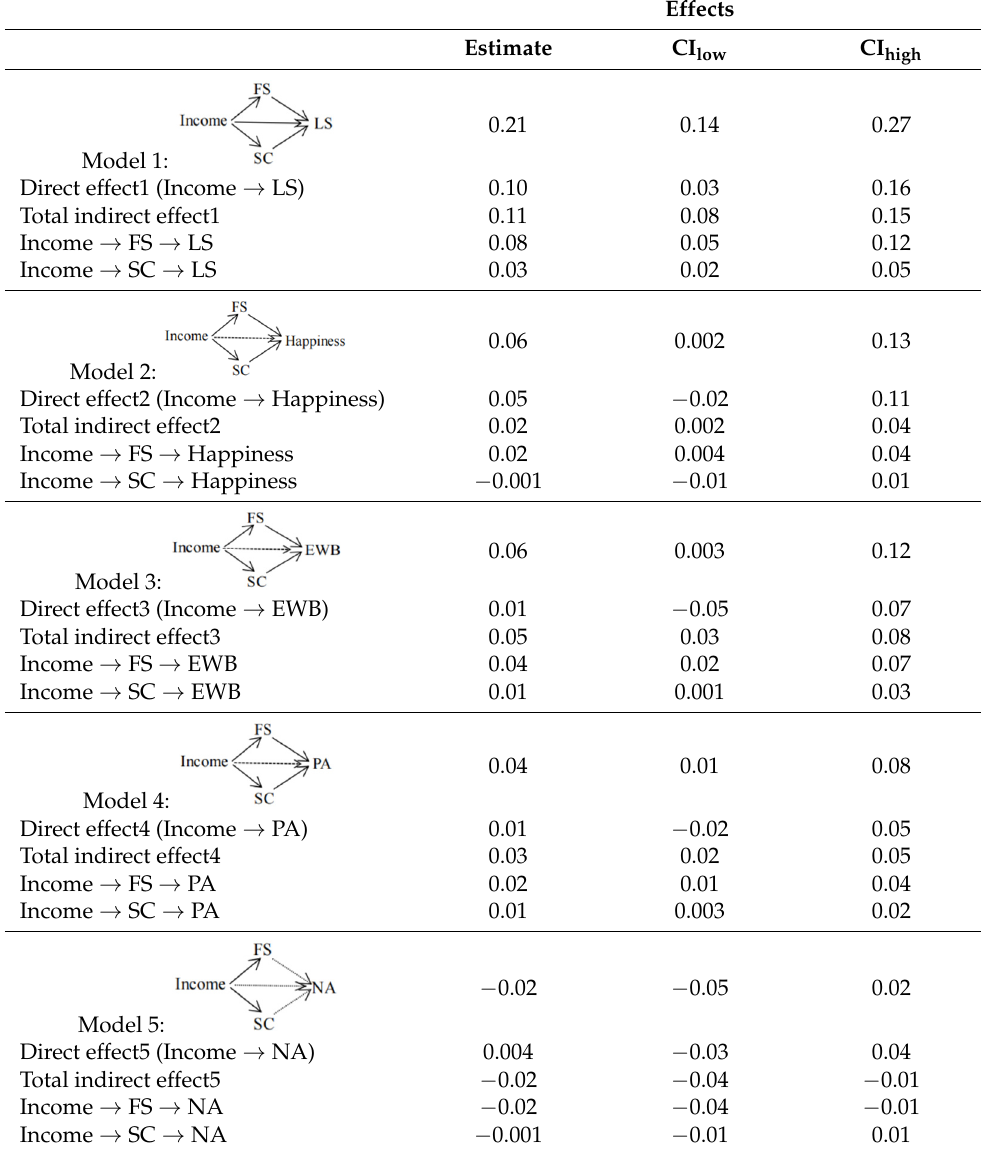
Table 5. Double mediation effect results in study 2.